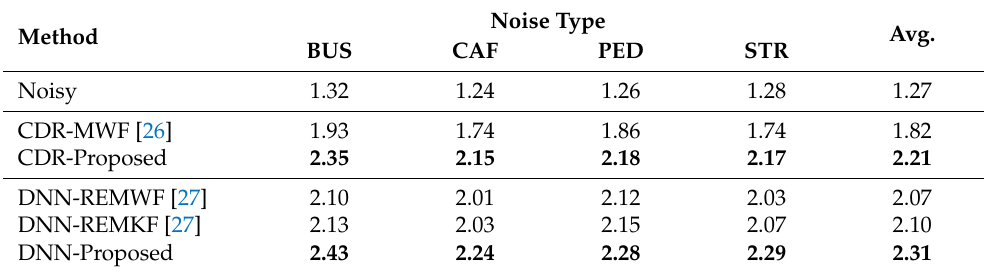
Table 1. The average PESQ scores for the different algorithms depending on the noise type.